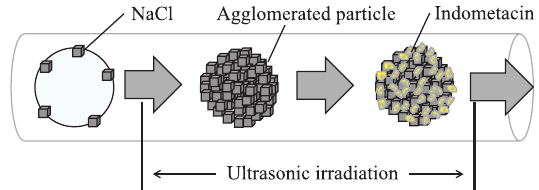
Fig. 9 Precipitation mechanism of composite particle with ultrasonic irradiation in a dispersed flow. Reprinted with permission from